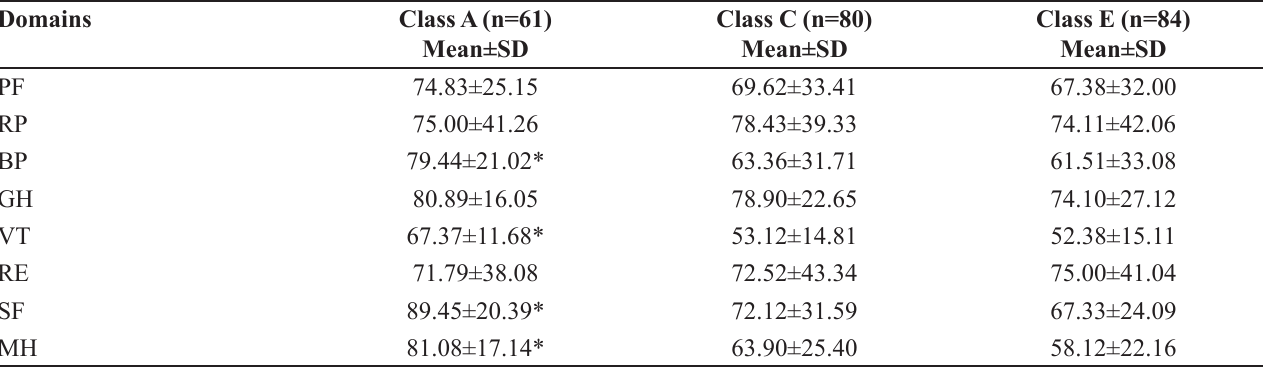
TABLE I - Mean (+SD) quality of life scores (SF-36) in elderly companionship groups. Porto Alegre/RS, 2007